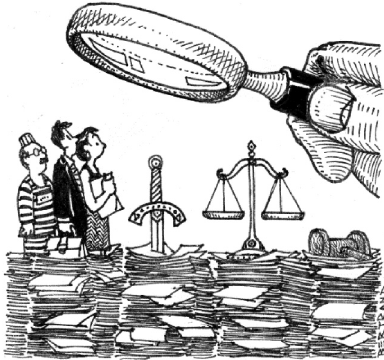
Figure 1. Administration